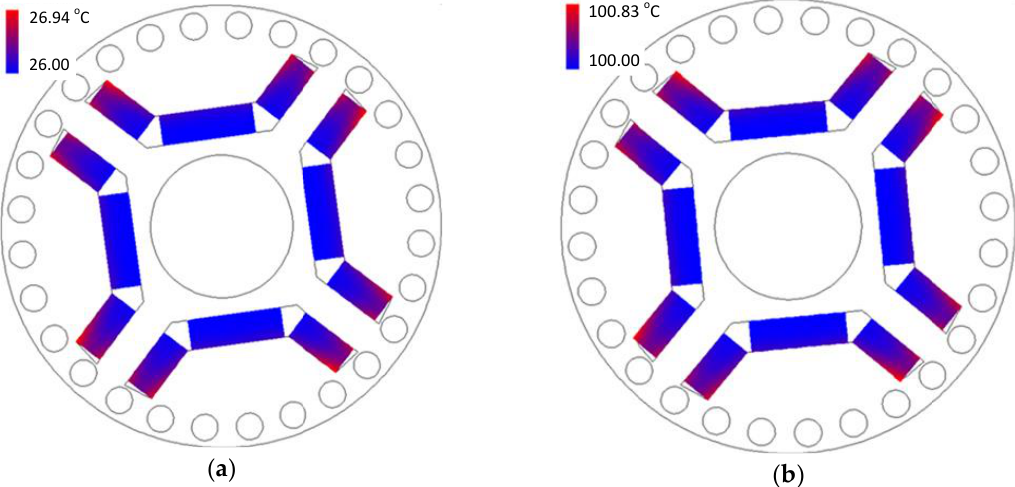
Figure 13. Temperature distribution in magnets in an electromechanical steady-state after start-up for t = 0.6 s, T L = 0 Nm, J i = 0.041 kgm 2 : ( a ) τ i = 26 ° C, ( b ) τ i = 100 ° C.